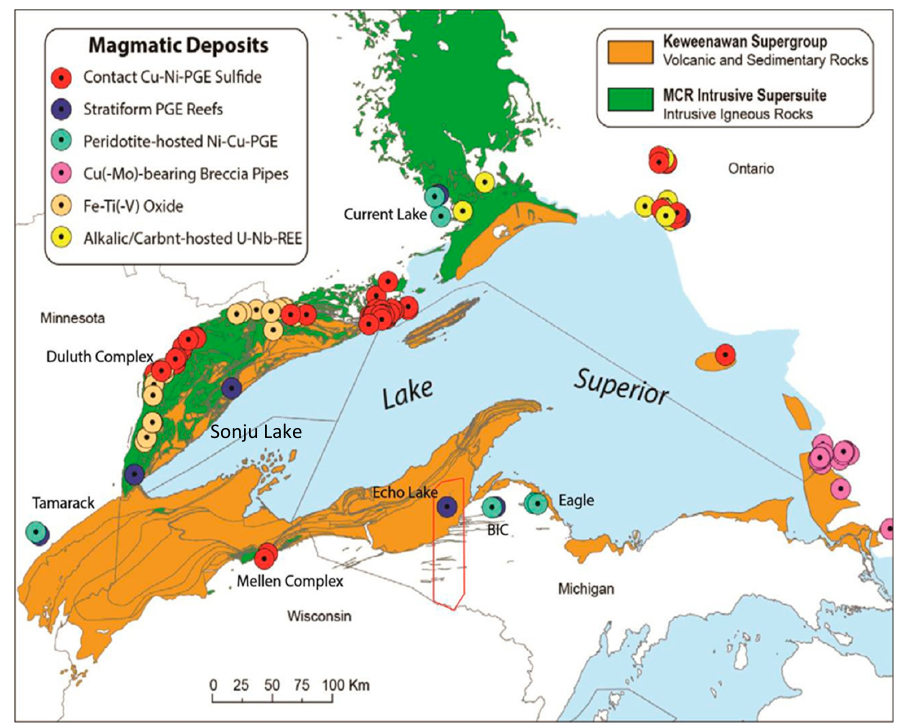
Figure 1. Magmatic ore deposits associated with the Midcontinent Rift around Lake Superior. The red box shows the location and extent of the exploration prospect zone called the Voyageur Lands [6,7].